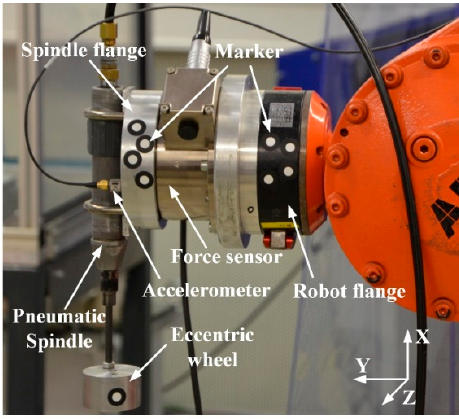
Figure 3. Stimulator and sensors.